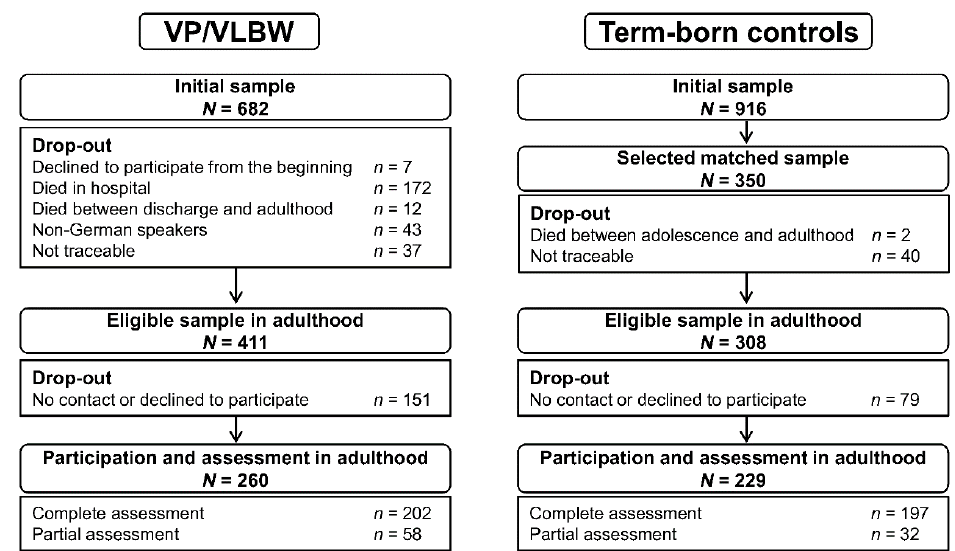
Figure 1. Eligible sample of very preterm and / or very low birth weight (VP / VLBW) and term control participants at age 26 years.